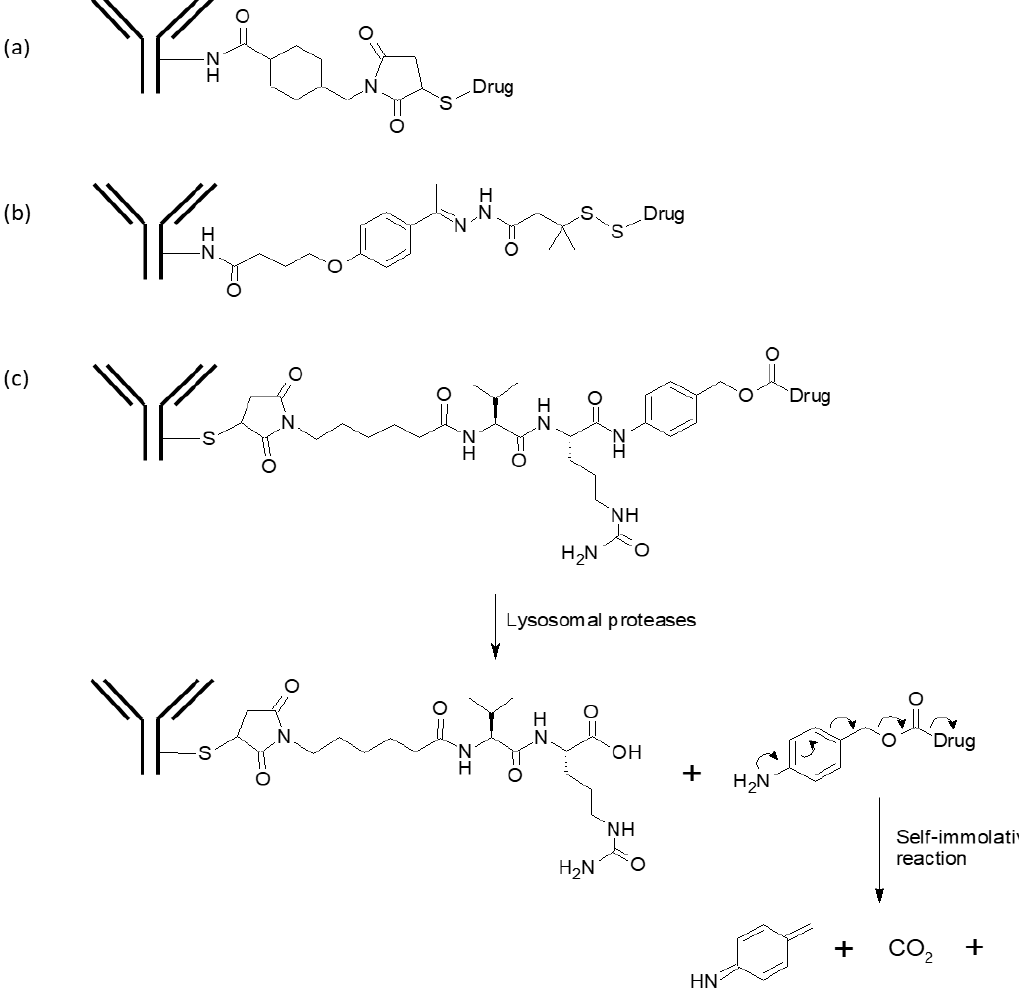
Figure 3. Representative structures of different types of ADC linkers. ( a ) Non-cleavable thioether linker of trastuzumab emtansine. ( b ) Acid-labile hydrazone linker of gemtuzumab ozogamicin and inotuzumab ozogamicin, with an additional disulfide linkage. ( c ) Enzyme-cleavable linker of brentuximab vedotin with Val-Cit motif.